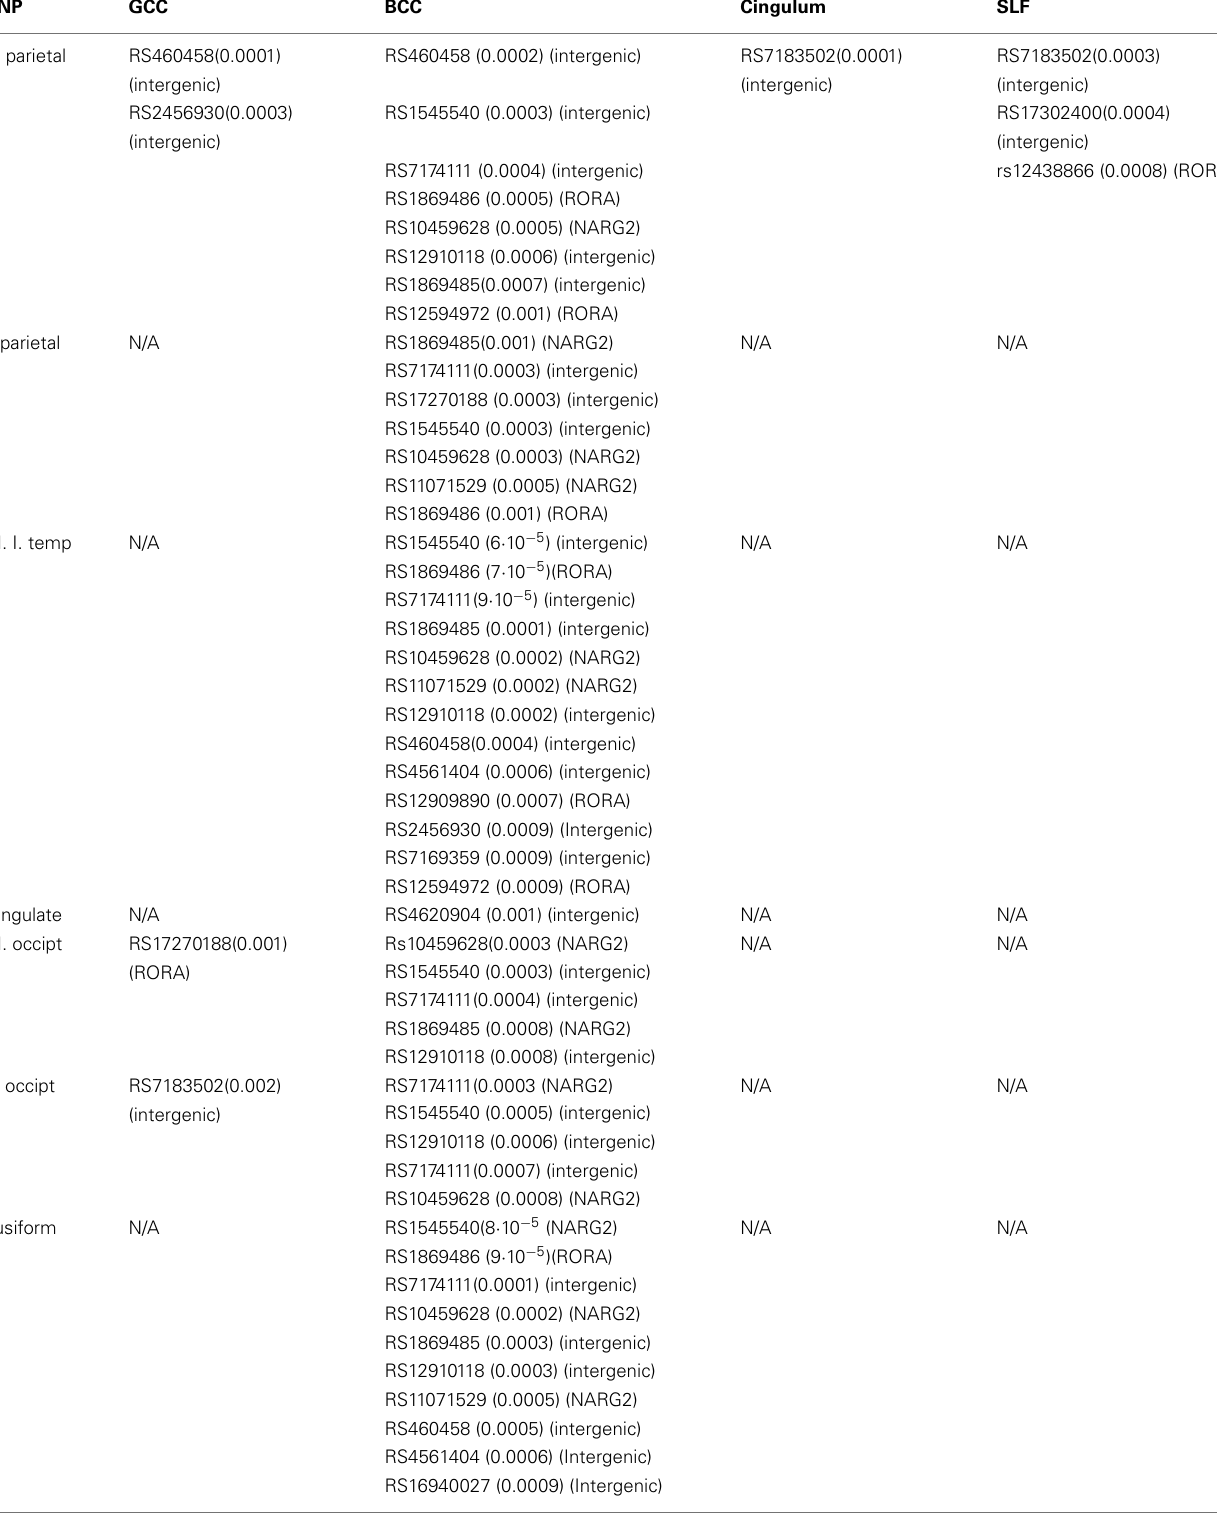
Table 4 | SNP name (p) and (genetic association) for the highest and all suggestively ( p ≤ 0.001) significant SNP